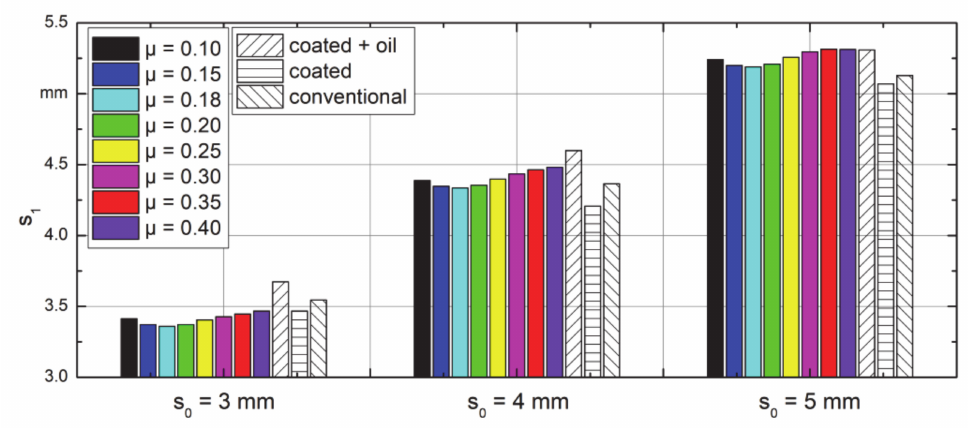
Figure 24. Wall thickness comparison between the FE model and